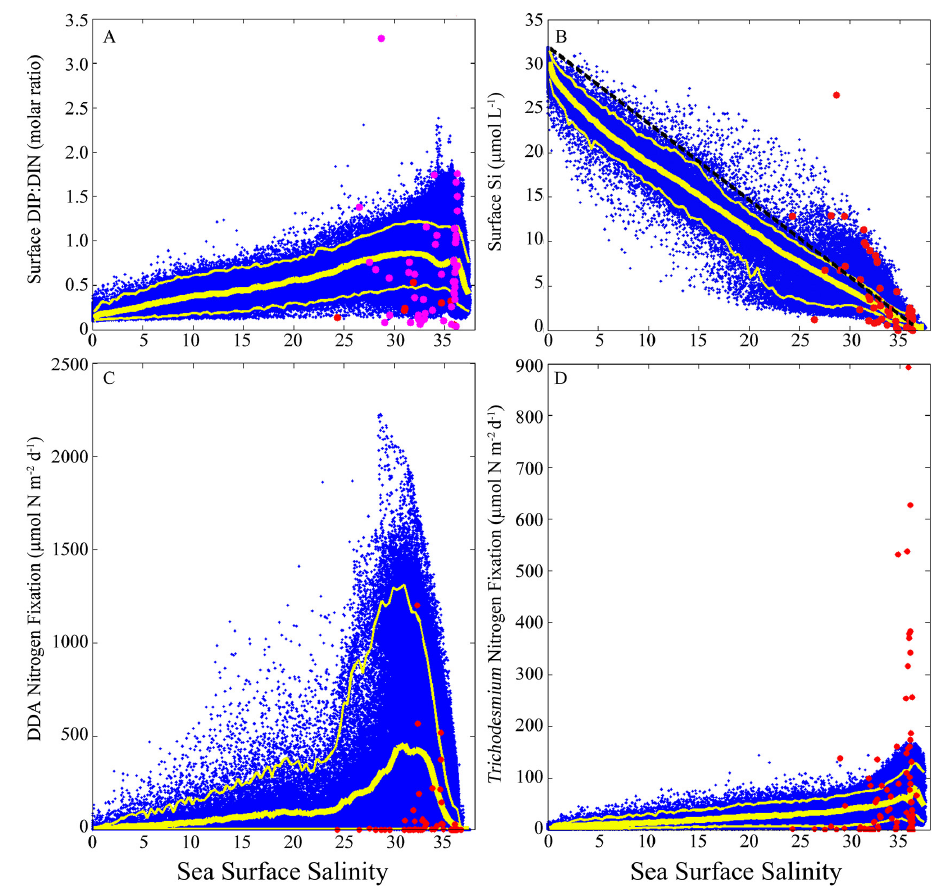
Figure 4. Model-data property-salinity comparisons in the ARP. In all plots, blue points are model values, large red dots are in situ measure- ments from Subramaniam et al. (2008), thick yellow line is model mean, thin yellow lines are the 95% confidence intervals. Panel (A) shows surface nutrient P:N molar ratios. Magenta points are data points from Subramaniam et al. (2008) for which NO 3 was at or below their detection limit of 0.05µM. Panel (B) shows surface Si concentrations (µmolL − 1 ) , with dashed black line showing the conservative mixing line. Panel (c) shows DDA nitrogen fixation (µmol Nm − 2 d − 1 ) . Panel (d) shows Trichodesmium nitrogen fixation (µmol Nm − 2 d − 1 )